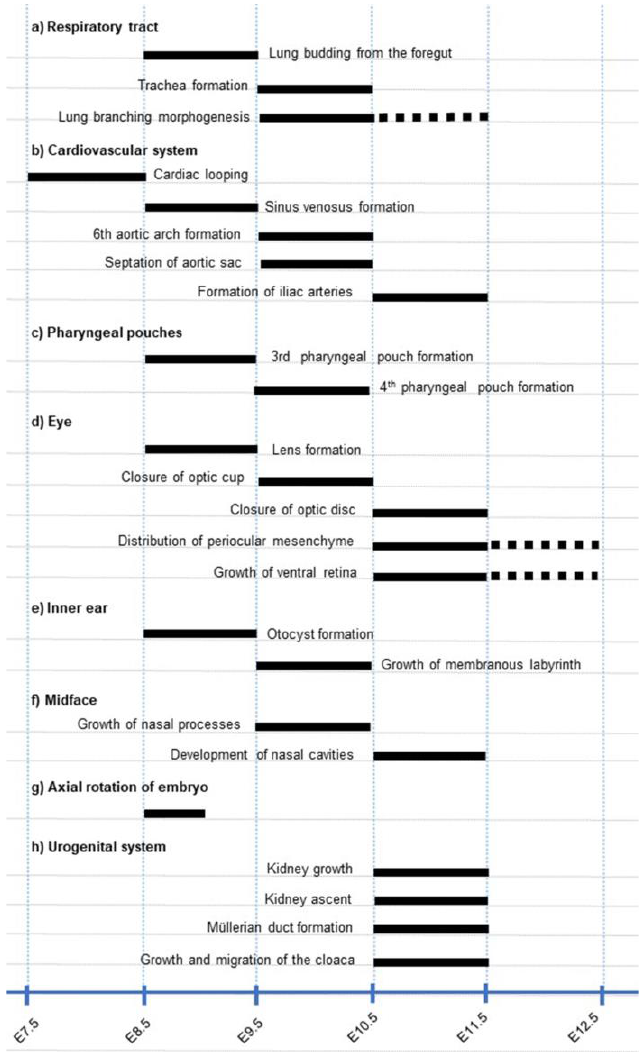
Figure 12. Critical periods in development requiring a functional RAR signalling pathway. The developmental processes analysed in Rarabg ΔE8.5 , Rarabg ΔE9.5 , Rarabg ΔE10.5 and Rarabg ΔE11.5 mutants are listed. Solid bars indicate the periods when impaired signalling through RARs causes major structural defects and stippled bars indicate the periods when the defects appear less frequent or less severe. For further details, see the main text and [4].